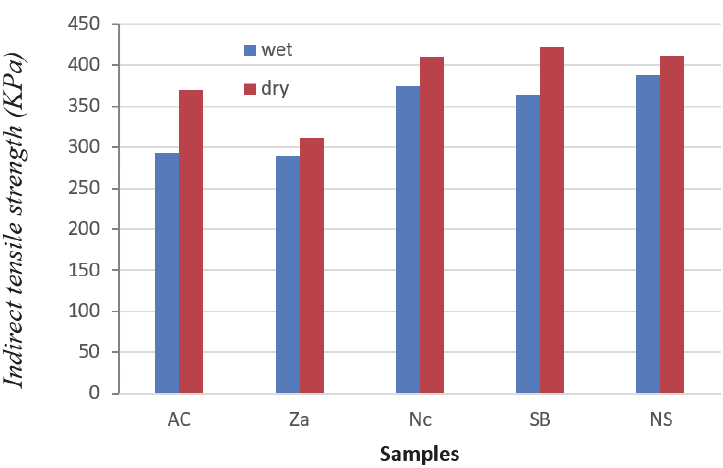
Figure 4: Results of indirect tensile strength for modified and non-modified